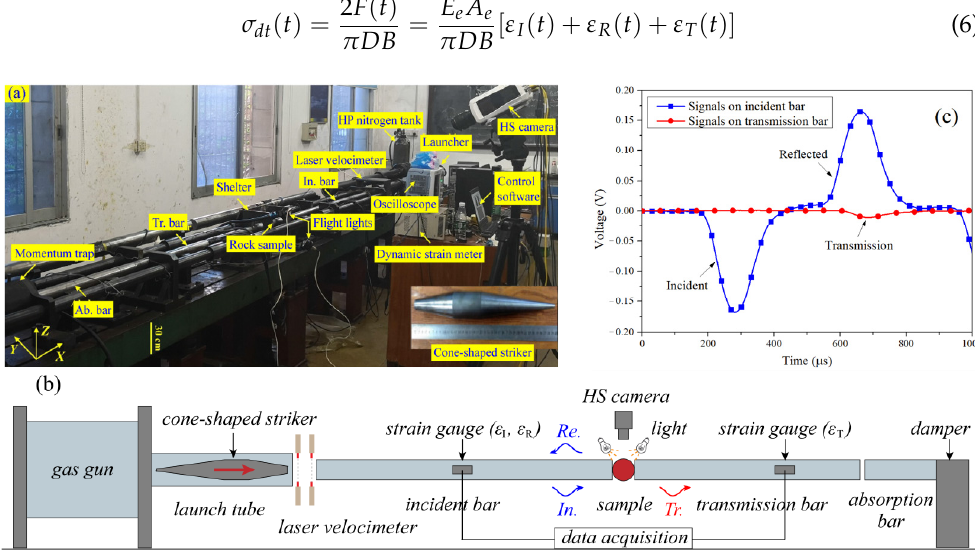
Figure 5. Photographic ( a ) and schematic diagram ( b ) of the modified split Hopkinson pressure bar system, and ( c ) typical data recording result.